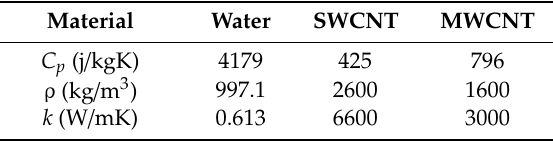
Table 2. Thermo-physical properties of base fluid and both type of carbon nanotubes (CNTs) i.e., SWCNTs and MWCNTs.